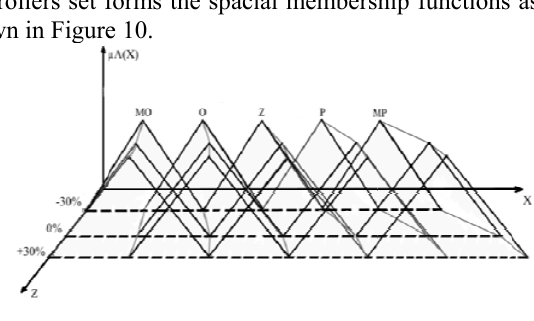
Figure 10. Spacial membership